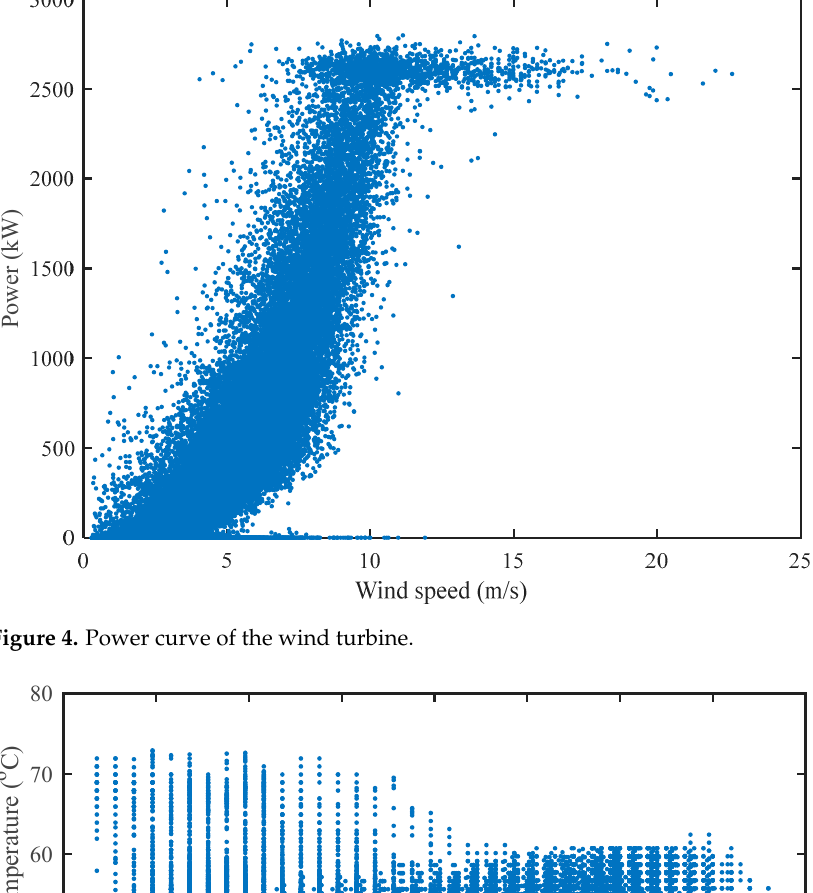
Figure 4. Power curve of the wind turbine.